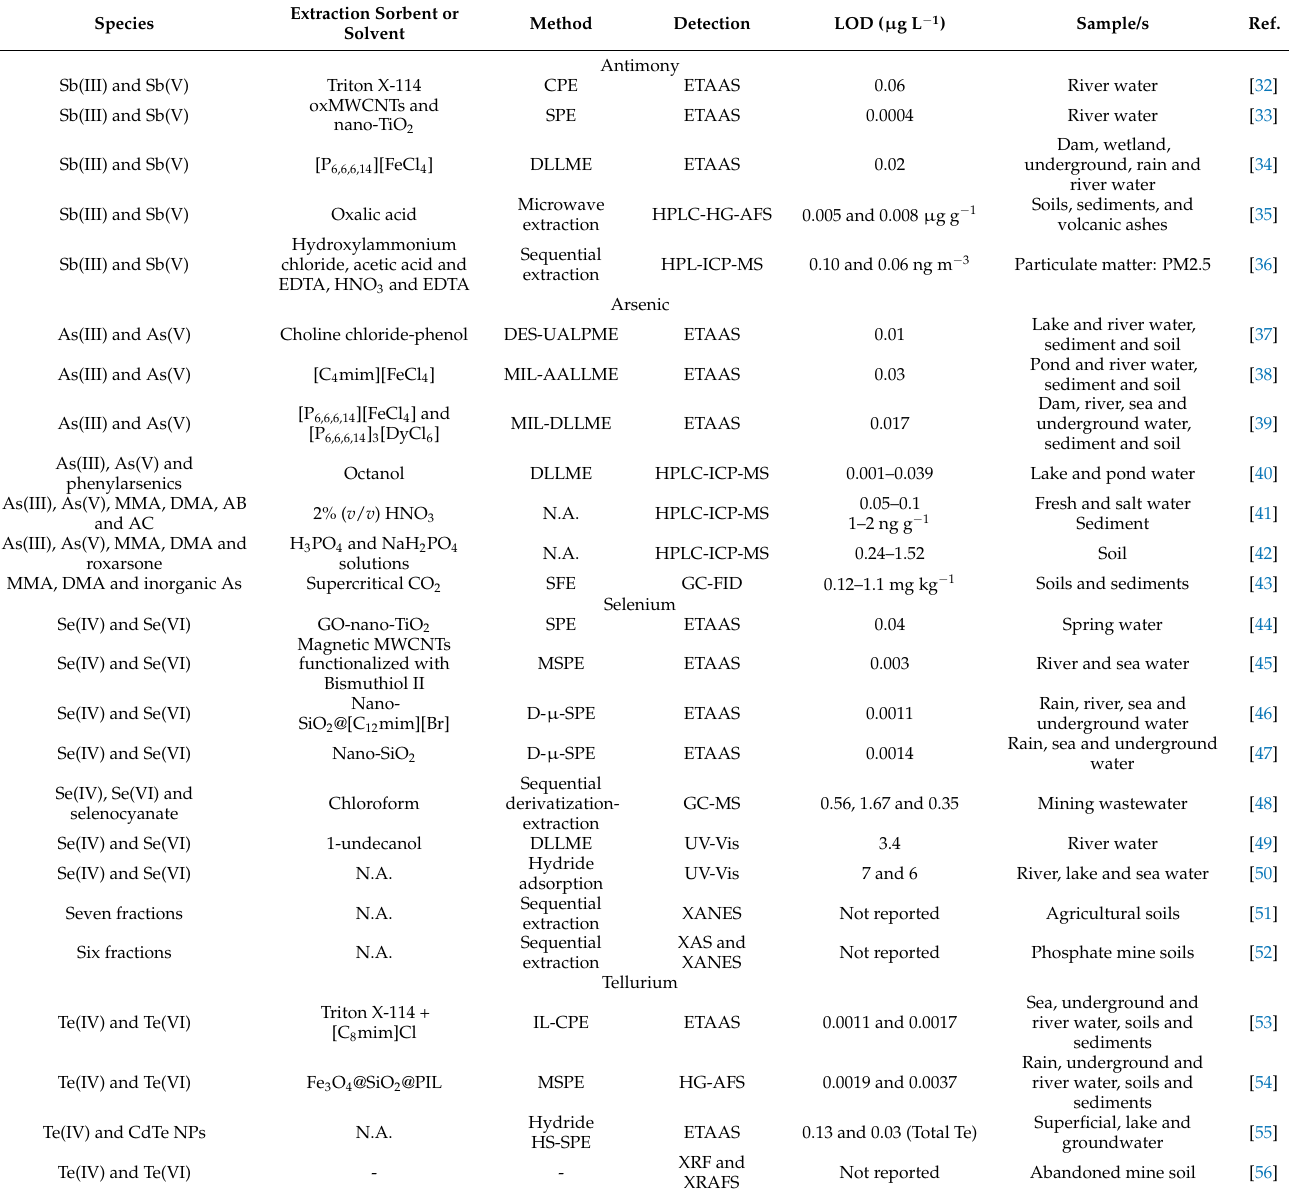
Table 1. Metalloid speciation analysis reports from 2016